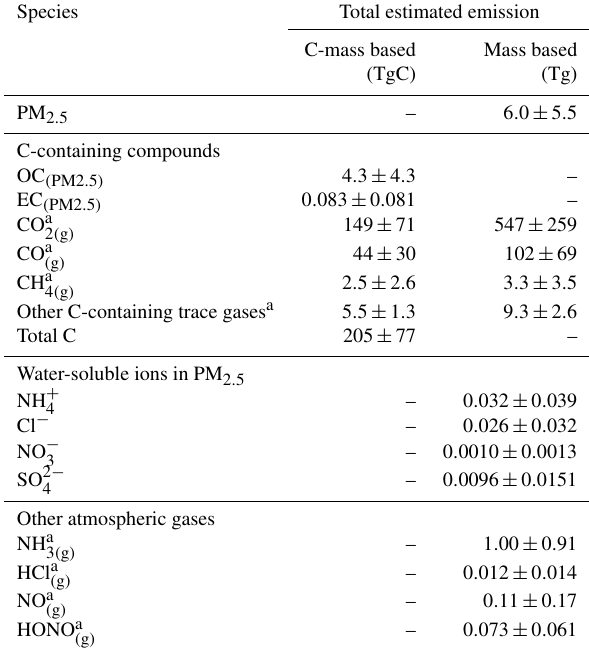
Table 3. Estimated emissions from Indonesian peat fires during 2015 El Niño, based on a burned area of 8 . 5 × 10 5 ha (Whitburn et al., 2016), an average burning depth of 34 ± 12cm (Stockwell et al., 2016), and peat bulk density 0 . 120 ± 0 . 005gcm − 3 (Konecny et al., 2016). The uncertainty of the estimated value is propagated us- ing standard deviations of the mean EFs, burn depth, and peat bulk